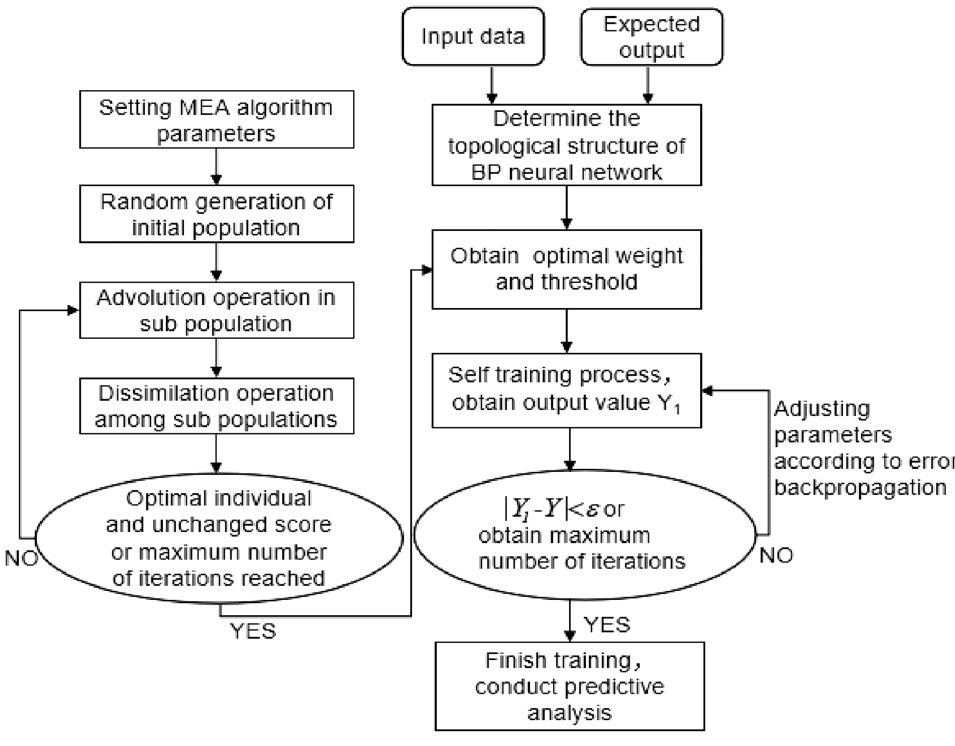
Figure 3. MEA-BP